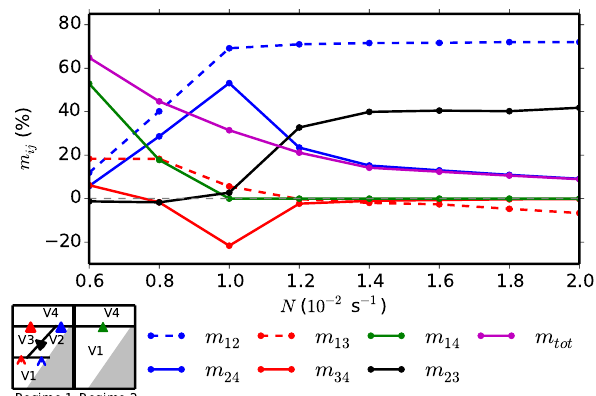
Figure 5. The total mass of tracer passing each interface between two volumes V i and V j and between 06:00 and 18:00LT, nor- malized by the total mass of tracer released at the valley floor, i.e. m ij = M ij /M 01 as a function of stability for the S1 forcing. The total exported tracer mass over the course of the simulation is m tot = m 24 + m 34 + m 14 . The bottom left is similar to Fig. 4b, ex- cept that the open arrowhead corresponds here to dashed